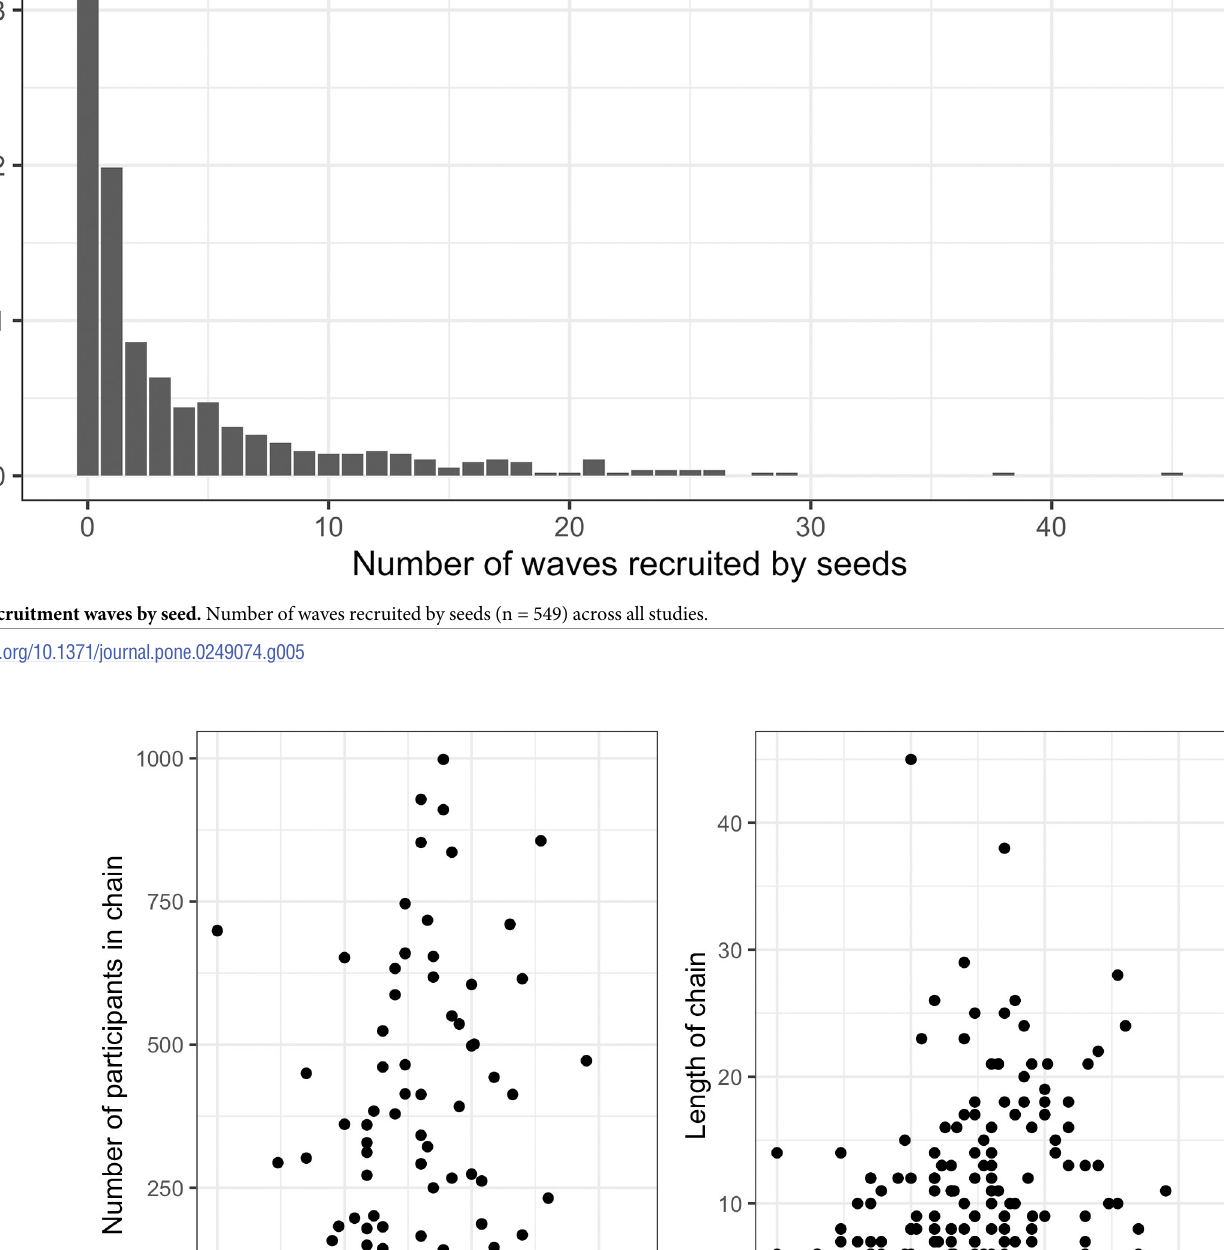
PLOS ONE | https://doi.org/10.1371/journal.pone.0249074 April 15,